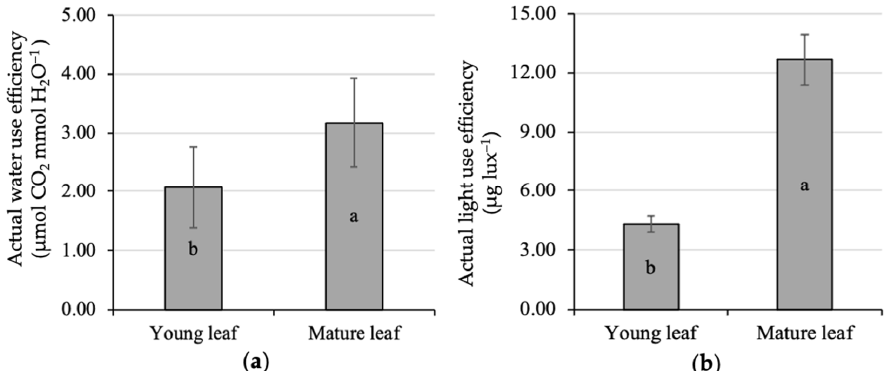
Figure 3. Comparative analysis of the actual water ( a ) and light-use efficiency ( b ) of young and mature kaffir lime leaves. Different letters inside the rectangular bar indicate a significant difference based on the LSD test at α 5%; the error bar represents the standard deviation.